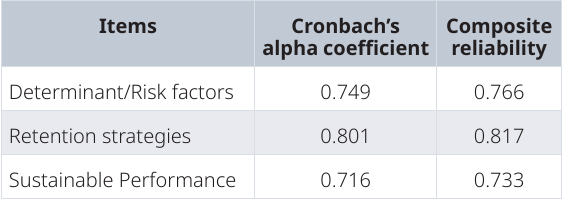
Table 1. Cronbach’s alpha and composite reliability